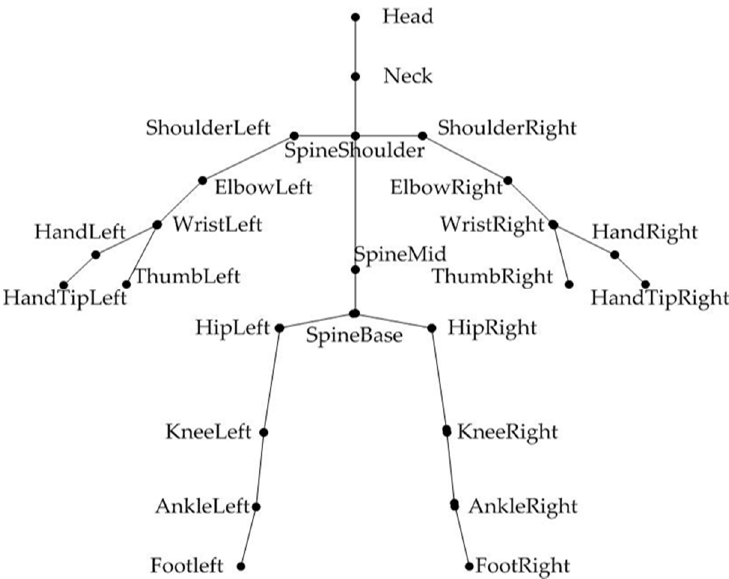
Figure 2. 25-joint human skeleton model of Kinect2.0.